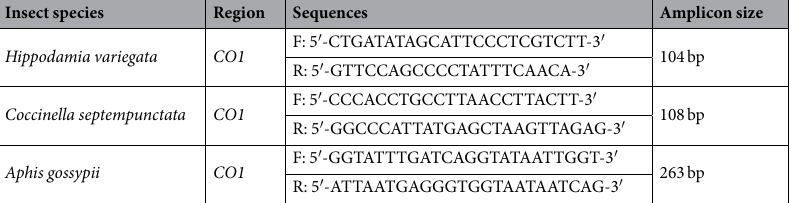
Table 1. Details of primer sequences designed on the Cytochrome Oxidase I ( COI ) mitochondrial region to detect DNA of Hippodamia variegata , Coccinella septempunctata and Aphis gossypii , and expected amplicon